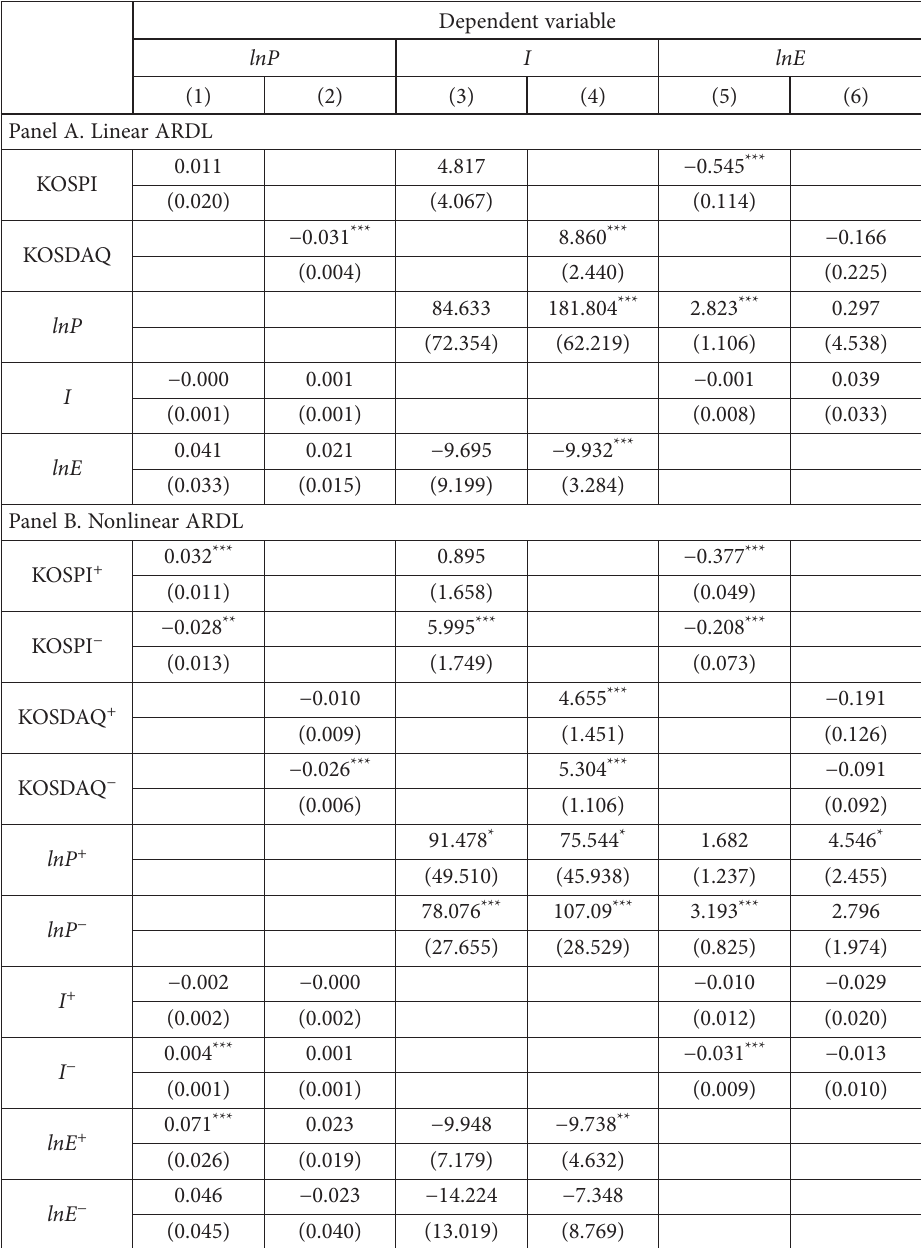
Table 6. Long-run coefficient: impact of stock price shocks on macroeconomic